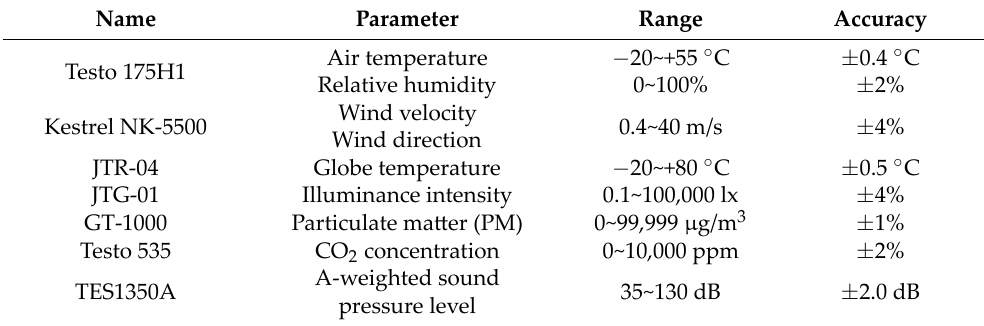
Table 3. Detailed information about the measuring device.